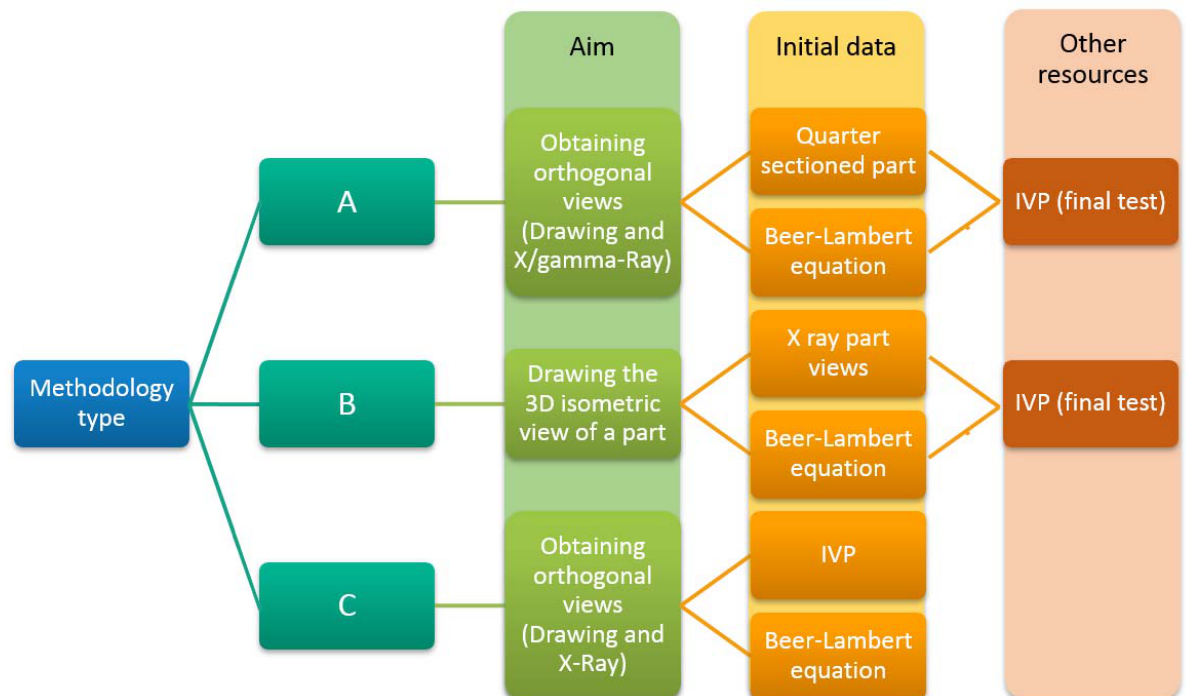
Figure 8. Diagram showing the proposed exercises described in this work. The gray gradient shown in radiographic images is directly related to spatial visual ‐ ization due to: (i) the gray coloration of radiographic views of a part depends on the thick ‐ ness of each zone of the part, as follows from the Beer–Lambert equation; (ii) the thickness traversed by the radiation beam in each zone of the part depends on the orthogonal view used to obtain the radiography. Through the resolution of the exercises described in this work, the spatial understanding of the part and the localization of its internal defects are